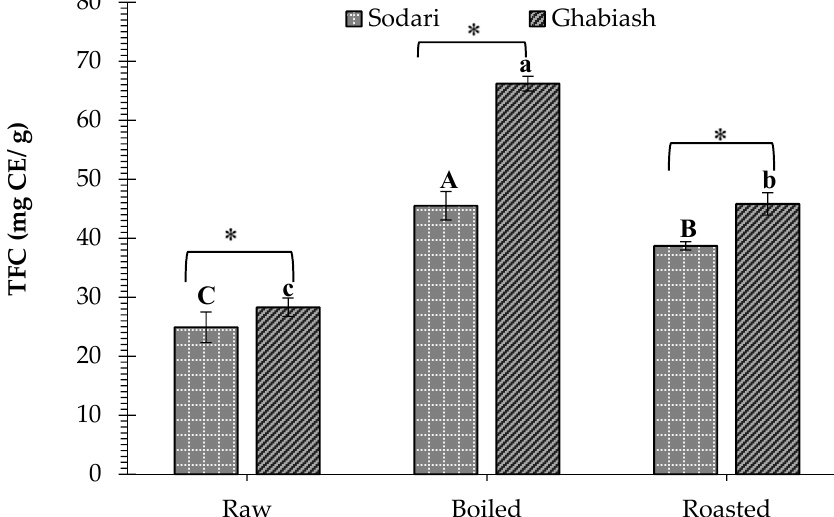
Figure 2. Effects of boiling and roasting on the total flavonoid content (TFC) of pod shells of peanut cultivars. Data represent mean ± SD ( n = 3). Values followed by the same letter are not significantly different ( p < 0.05) as evaluated by LSD. Capital letters indicate significant differences between raw and processed samples of Sodari cultivars, whereas lower case letters indicate significant differences between raw and processed samples of Ghabiash cultivar. * shows the significant differences between means of cultivars, while ns shows the insignificant differences between means of cultivars in the raw and processed samples.